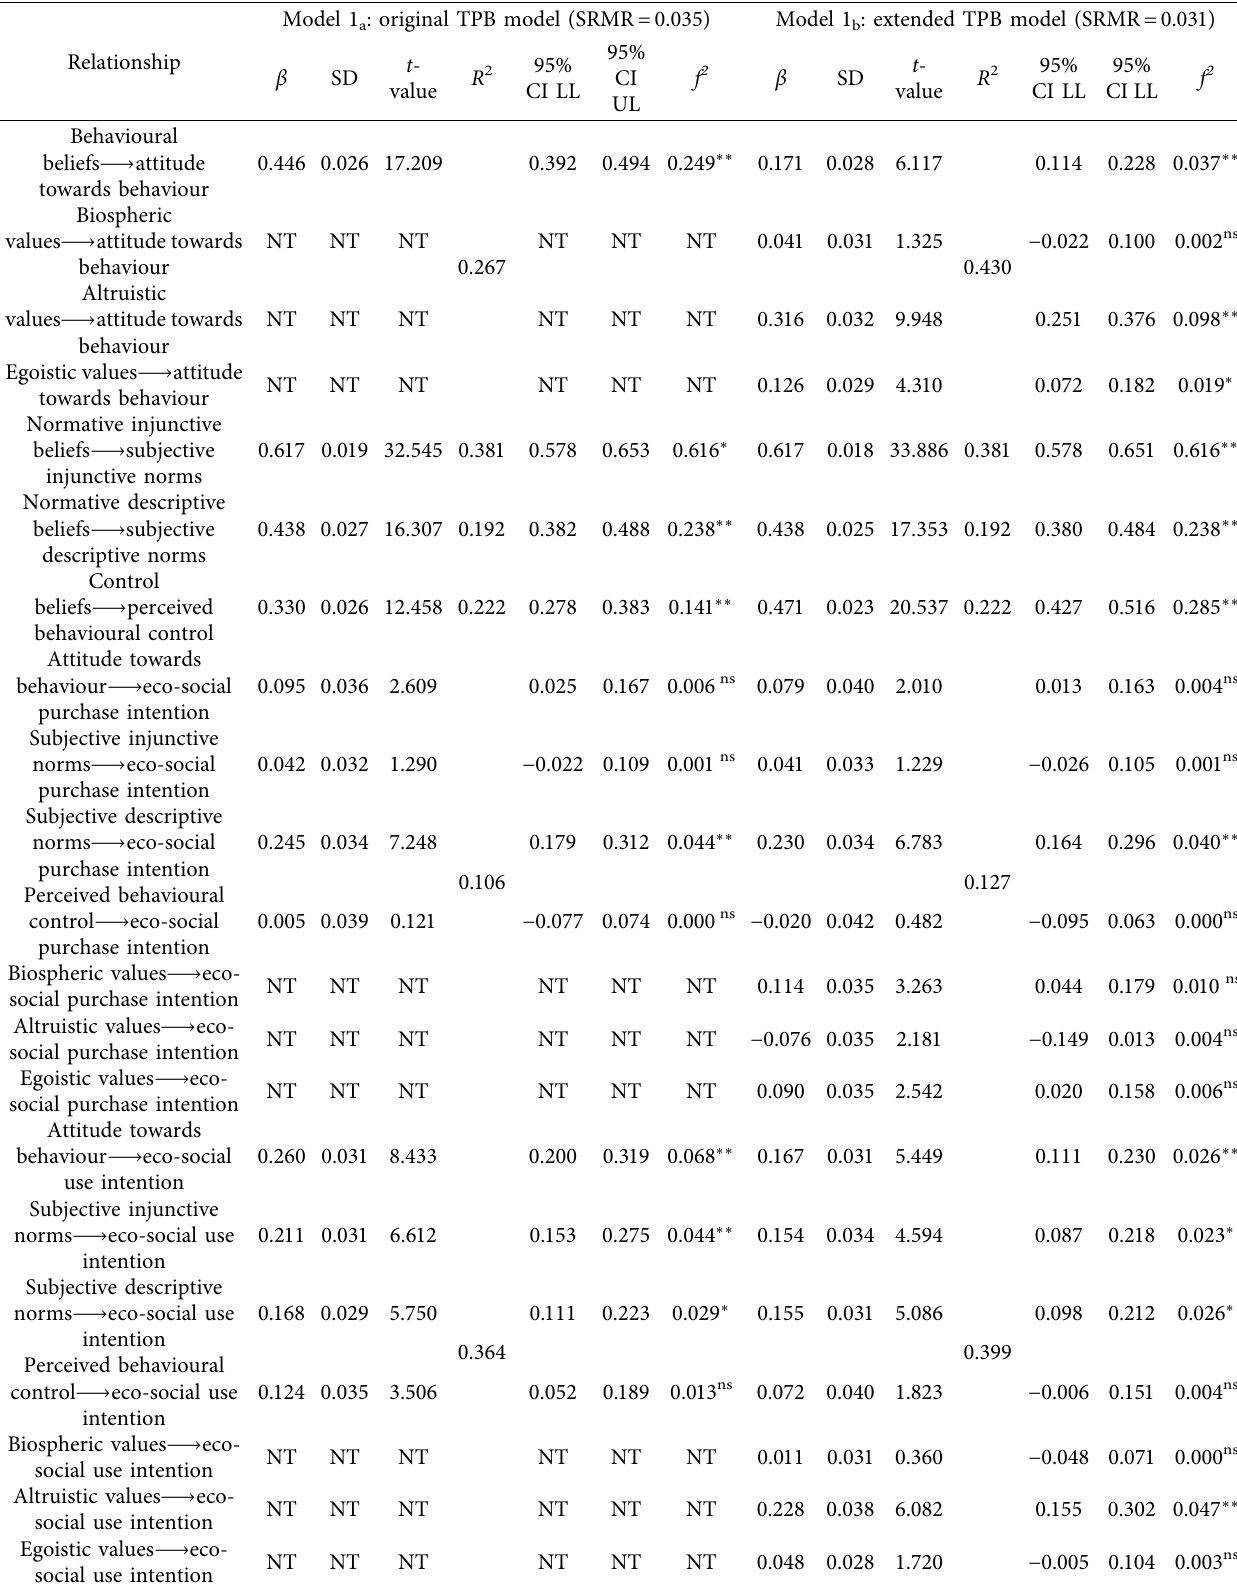
Table 5: Estimates of direct